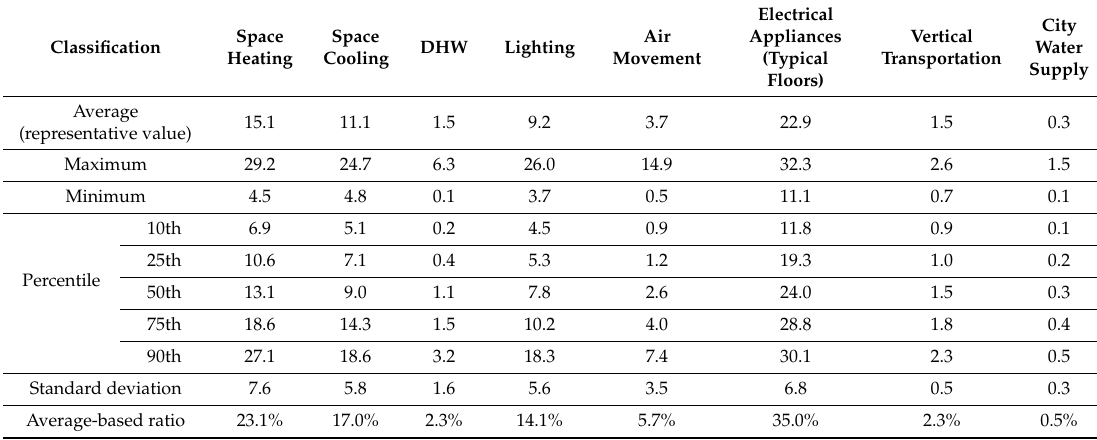
Table 14. Statistics of greenhouse-gas-emission intensities (kgCO 2eq / m 2 ·